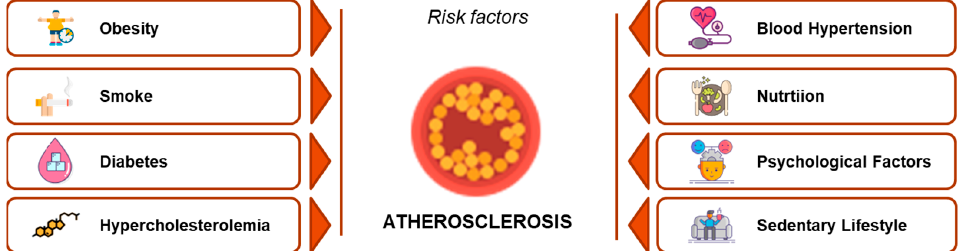
Figure 1. The main cardiovascular risk factors, derived from the INTERHEART Study data. Hypercholesterolemia is highlighted in red, as it is one of the most remarkable risk factors in pediatric age (adapted from reference [7]).